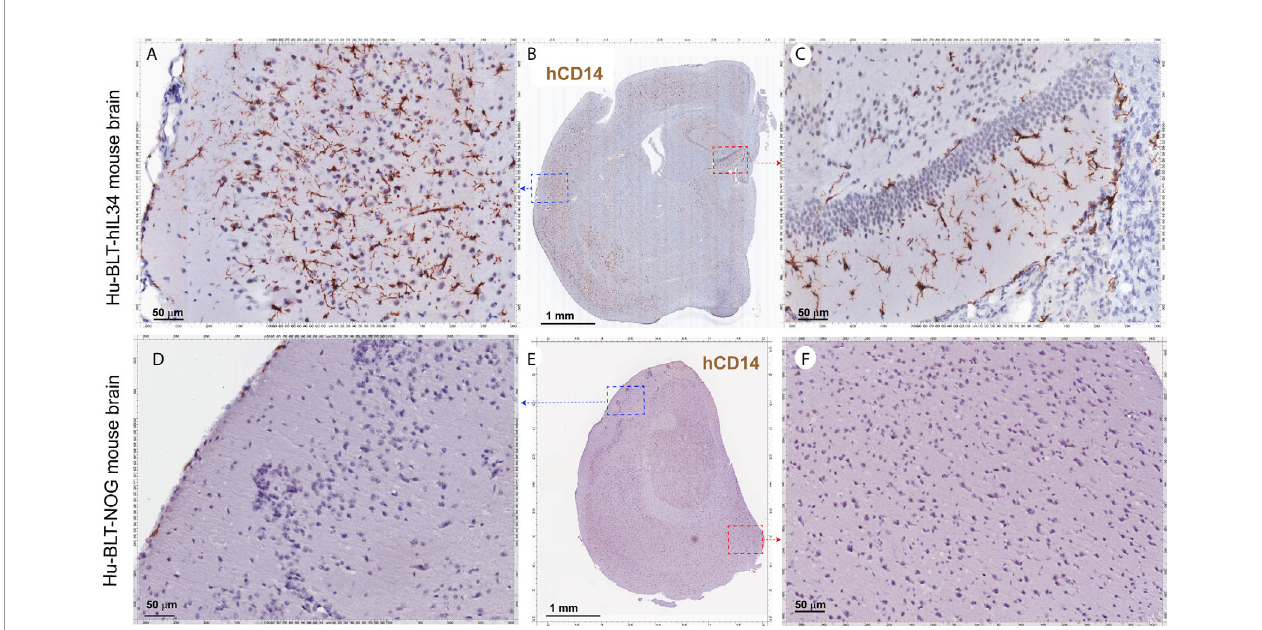
FIGURE 3 | The hCD14+ myeloid cell reconstitutions in the brain tissues of hu-BLT-hIL34 BLT and hu-BLT mice. The upper panel (A – C) shows representative whole brain tissue sections and the highlighted images form the corresponding boxed regions from hu-BLT-hIL34 mouse (#1708) that were stained immunohistochemically for hCD14+ cells (brown) and counterstained with hematoxylin. There were abundant hCD14+ cells (A – C) in the brain of the hu-BLT-hIL34 mouse. The lower panel (D – F) in contrast shows no detectable hCD14+ myeloid cells in the brain parenchyma and a very limited number of hCD14+ cells in meninges in a representative whole brain tissue section of a hu-BLT mouse